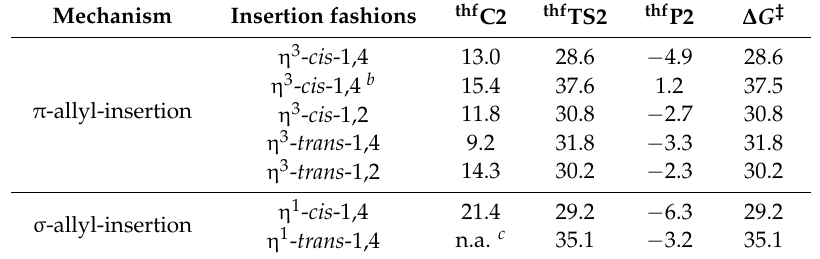
Table 1. Energy profiles a for insertion of the second butadiene into the metal–butenyl bond of thf P1 cis . Mechanism Insertion